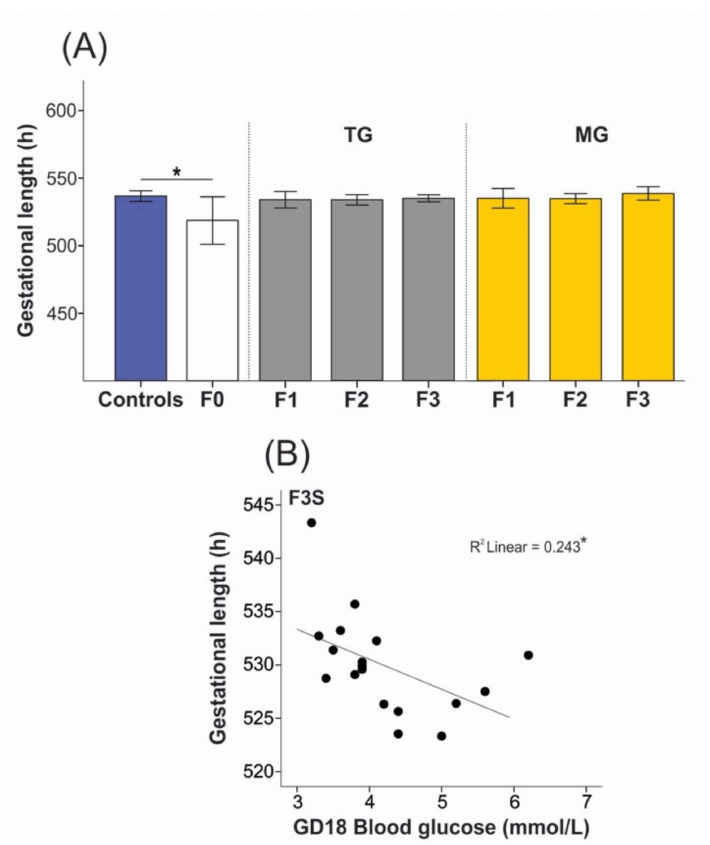
Figure 2. Social isolation stress significantly reduced gestational length of the F0 dams but did not impact the offspring’s pregnancy duration. ( A ) Gestational length recordings demonstrated shorter gestation in the parental generation F0, while no changes were seen in the TG or MG offspring. ( B ) For the F3 generation animals of both TG and MG groups, higher blood glucose levels were associated with shorter gestation in F3 stressed animals on gestational day (GD)18. Asterisks